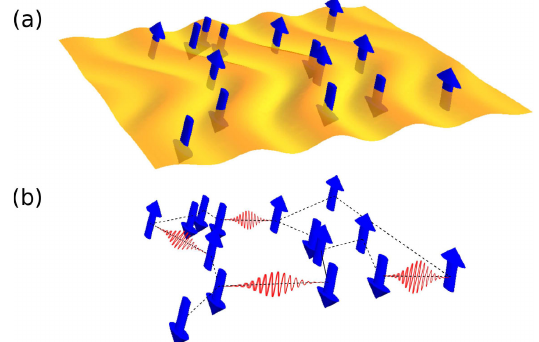
FIG. 6. Light-mediated interactions offer a highly versatile platform to design and control networks of interacting qubits. (a) The qubits (blue arrows) are embedded in an electromagnetic environment, which is the solution of the Maxwell equations in a given scattering geometry. (b) Integrating out the EM degrees of freedom yields effective interactions between the qubits, forming a network that can sustain large-scale entangled many-body